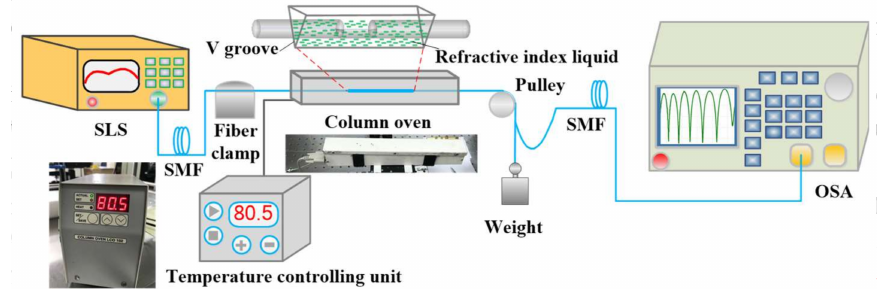
Figure 4. Schematic diagram of the experimental setup for the temperature measurement system. Insets, the physical photographs of the two separated parts of temperature oven: a column oven and the temperature controlling unit.